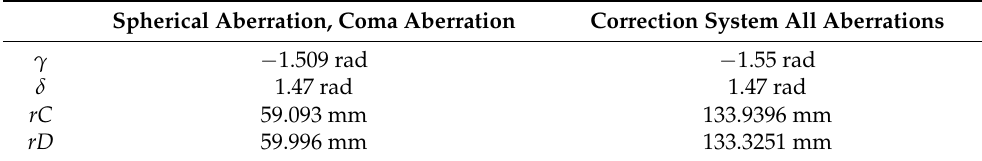
Table 1. Recording parameters of the aberrated off-axis Fresnel zone plate.